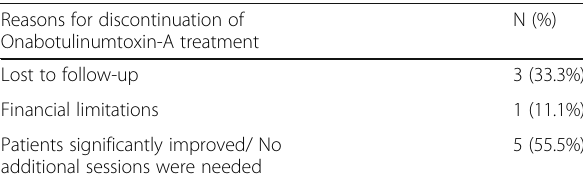
Table 2 Reasons for discontinuation of onabotulinumtoxinA treatment ( n =